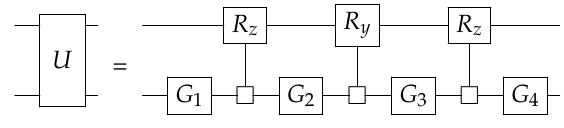
Figure 10. Quantum Shannon Decomposition [22].